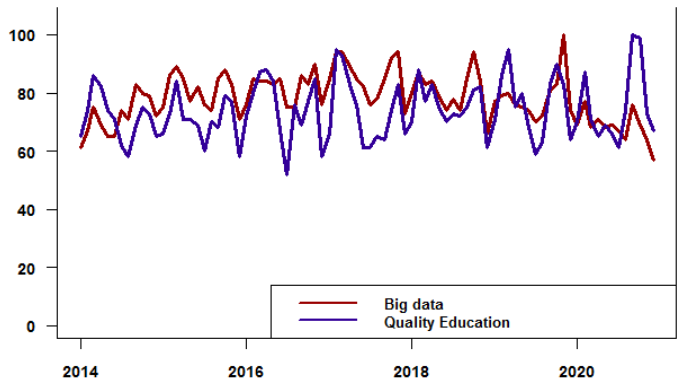
Figure 5. Big Data and SDG 4 global Google trends since